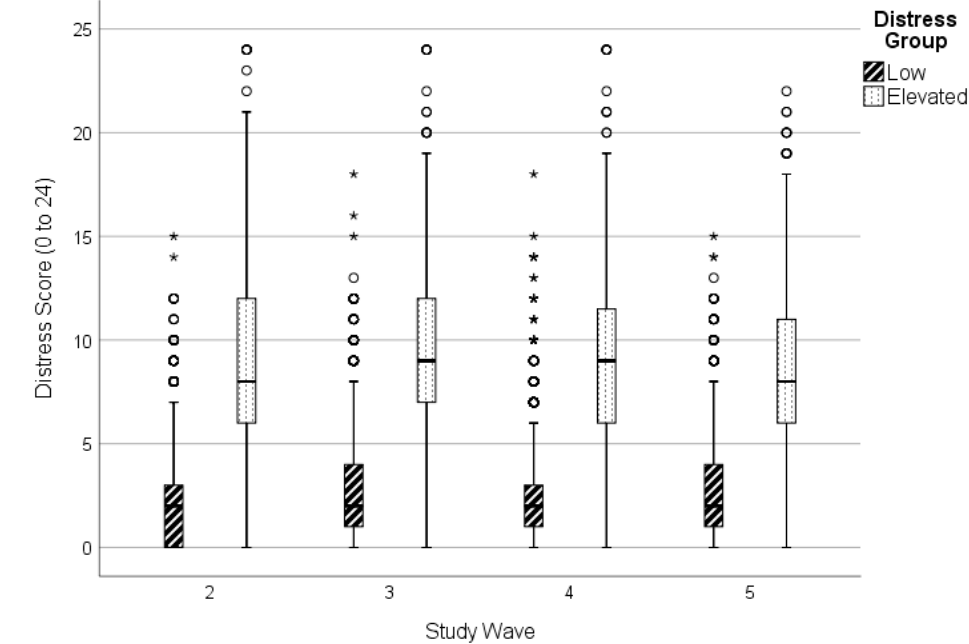
Figure 2. Trajectory patterns of psychological distress over four waves.